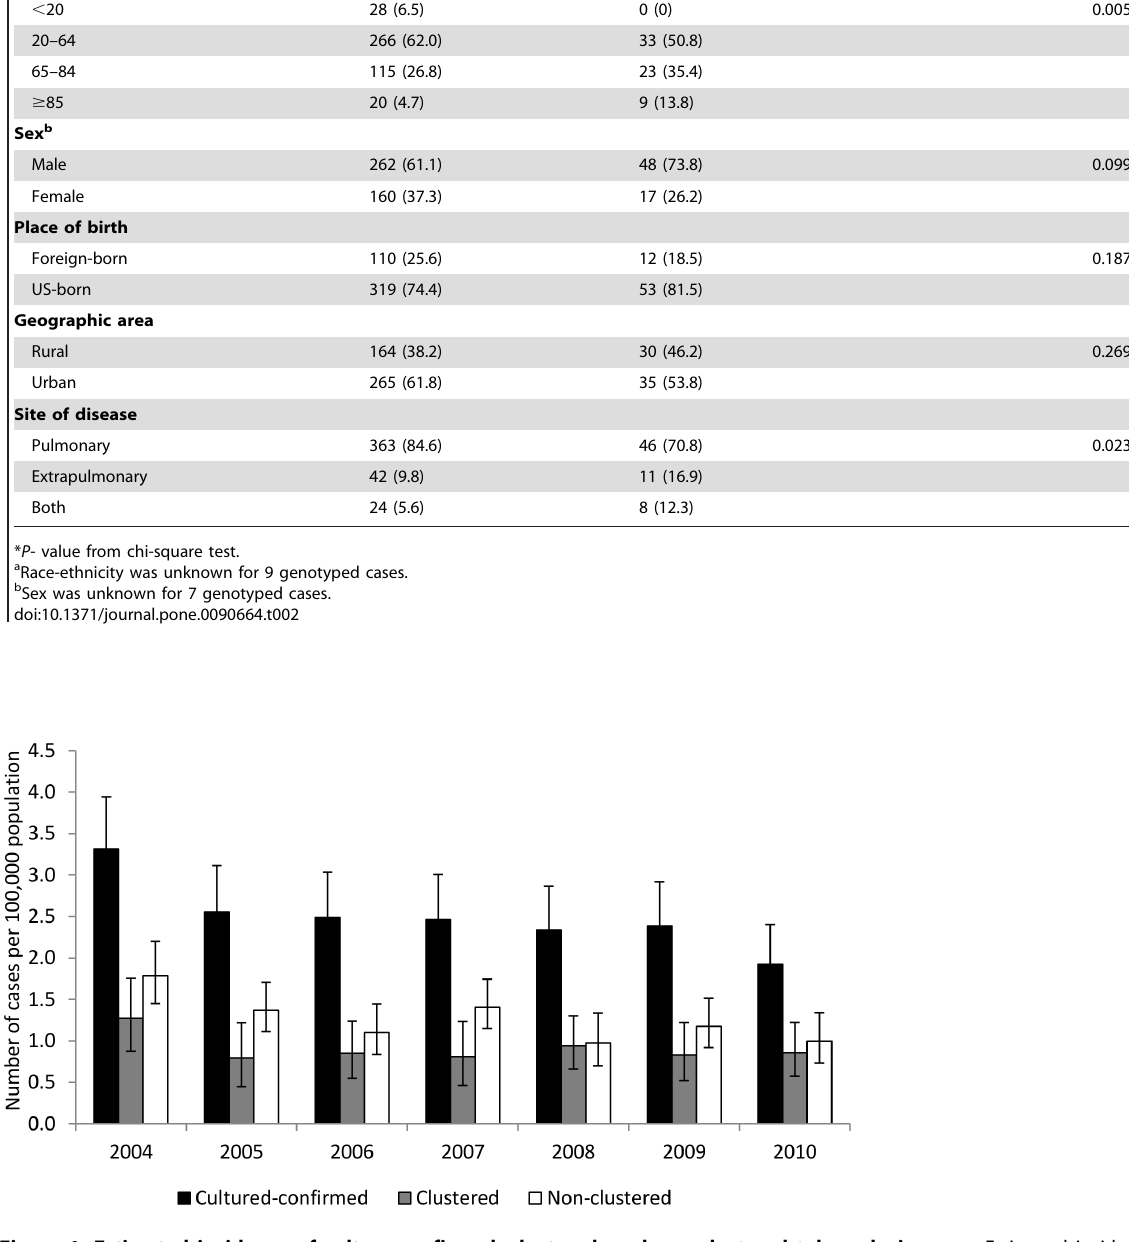
Figure 1. Estimated incidence of culture-confirmed, clustered, and non-clustered tuberculosis cases. Estimated incidence and 95% confidence intervals of culture-confirmed, clustered, and non-clustered cases of tuberculosis reported in Arkansas from 2004 to 2010. A case was included in a time-restricted cluster if it had identical spoligotype and 12 loci MIRU to another isolate diagnosed within the 1-year period prior to its diagnosis date. doi:10.1371/journal.pone.0090664.g001 PLOS ONE |